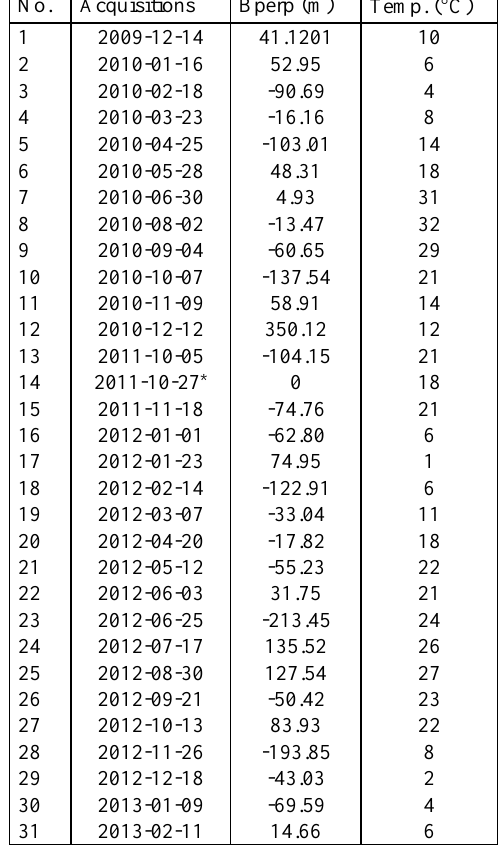
Table 2. Interferometric parameters of TerraSAR-X acquisitions in conjunction with the corresponding temperature data. The acquisition of 2011-10-27 (indicated by ‘*’ symbol) is selected as the reference image for the interferogram generation to minimize spatial-temporal decorrelation.